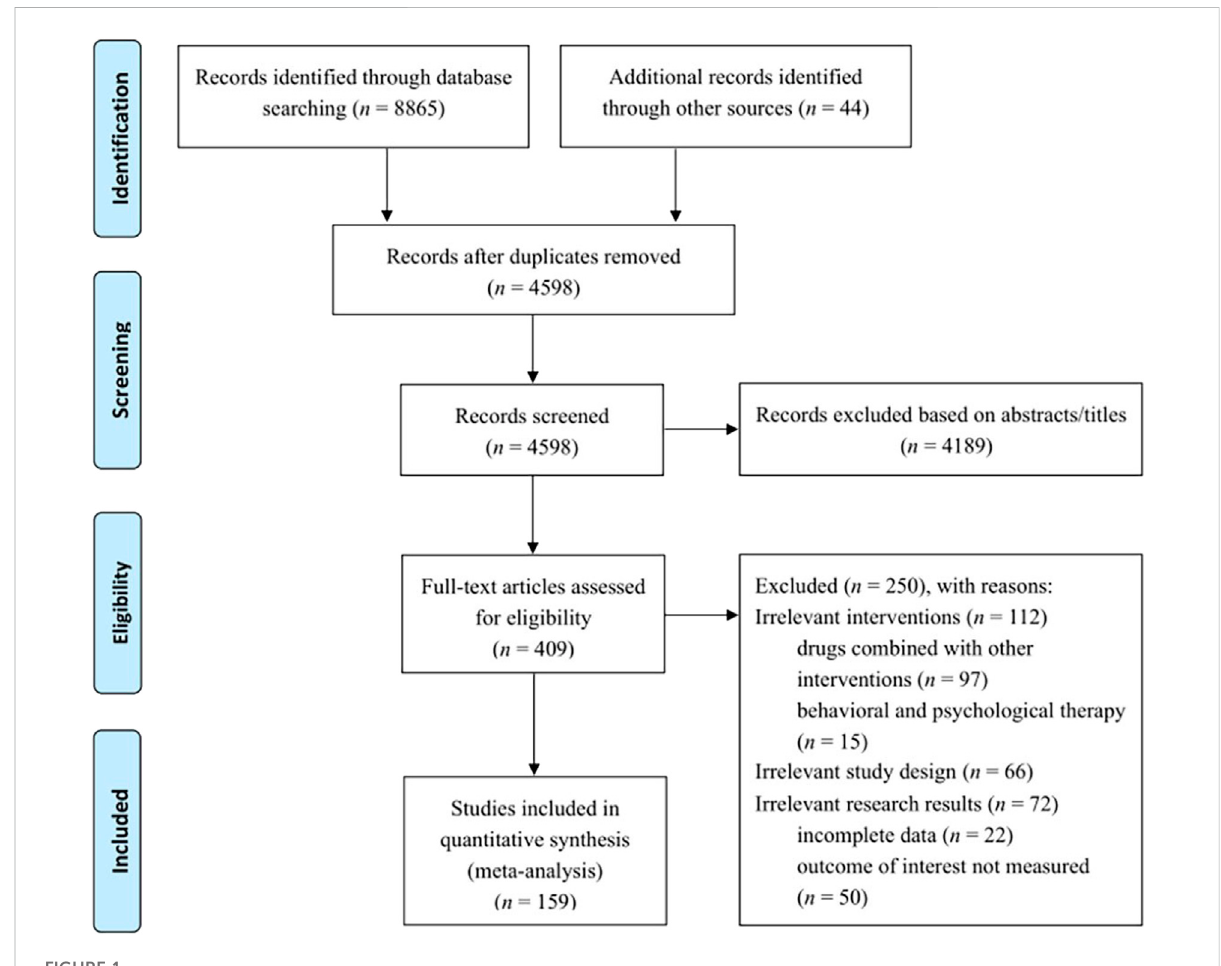
FIGURE 1 Literature screening fl ow